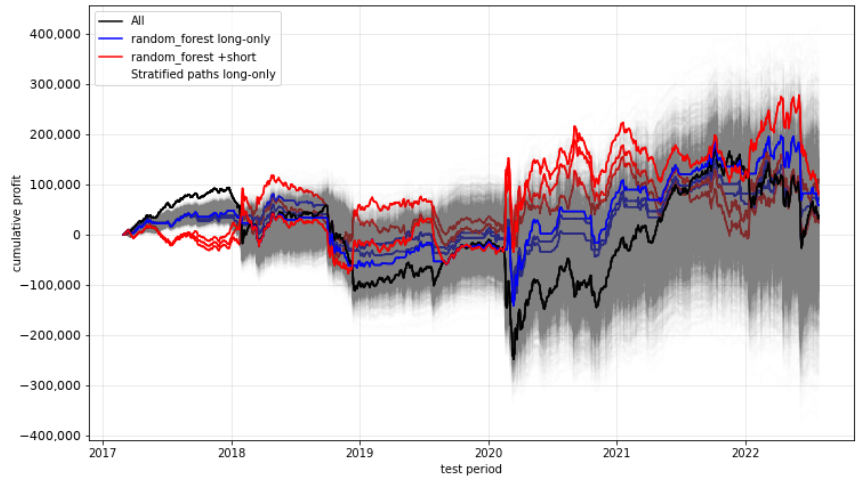
Figure 7. Cumulative profit of the random forest predictions.